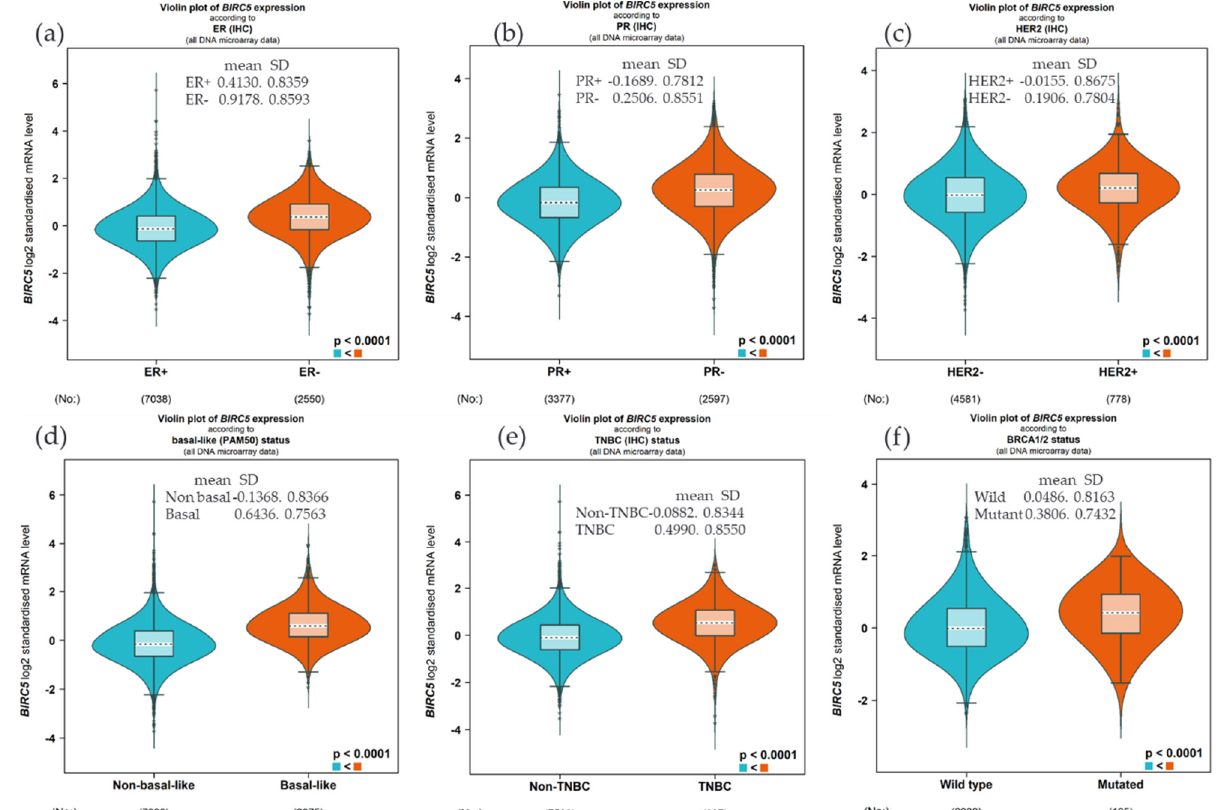
Figure 2. Expression of BIRC5 based on hormone status and BRCA1/2 mutation. Compared to the ER+, the BIRC5 expression was substantially upregulated in ER - patients ( a ), and the expression was high in PR − and HER - compared to PR + ( b ) and HER2 + ( c ). Compared to non-basal ( d ) and non-TNBC patients ( e ), the expression was high in basal and TNBC patients. The mRNA BIRC5 expression was higher in the BRCA1/2 mutant compared to the wild type ( f ).